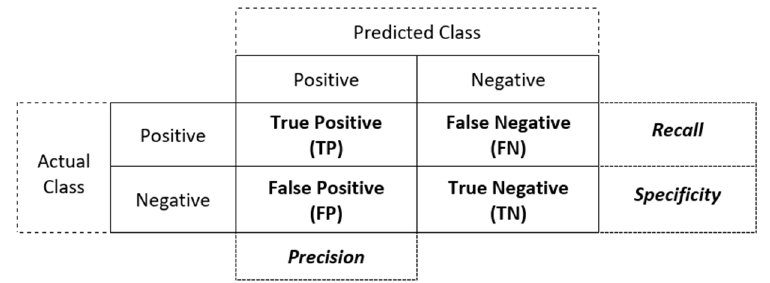
Figure 4. Confusion matrix setup.